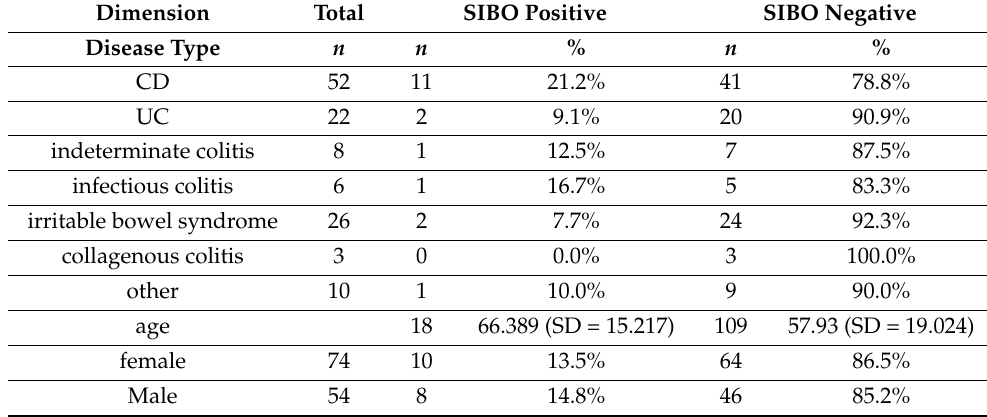
Table 4. Patients with positive SIBO test in accordance with the underlying disease, sex, and